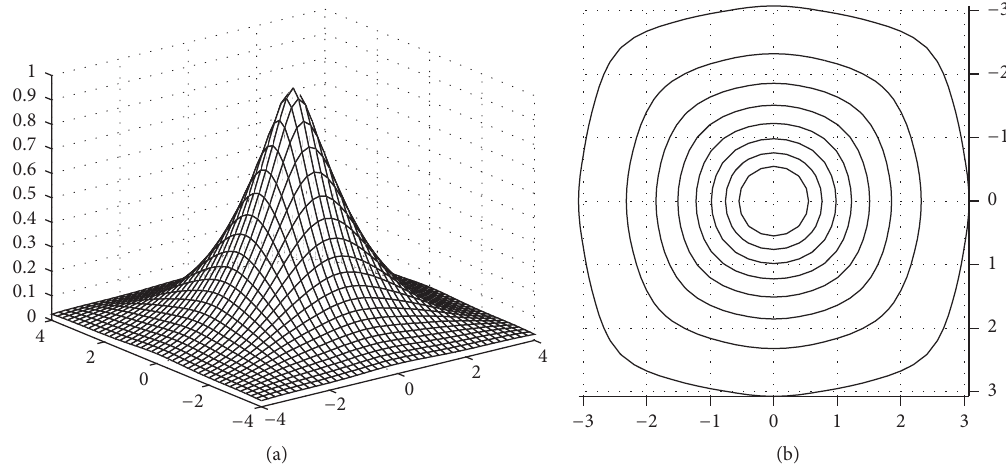
Figure 3: 𝜙 𝑔 with w = 0.8 (a) and its level sets (b). 0 , w